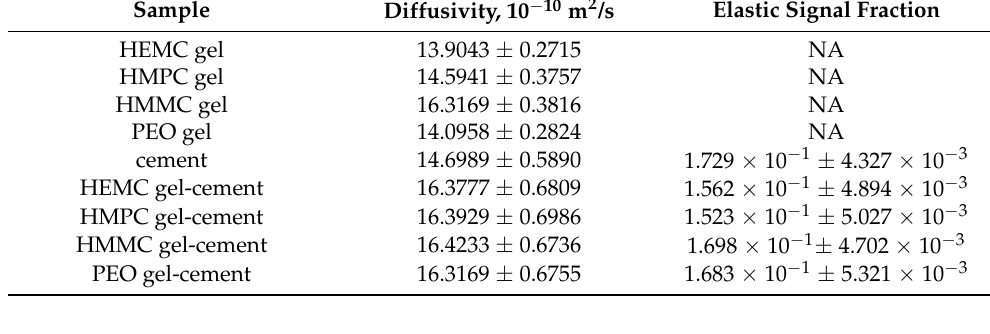
Figure 11. Hydration Calorimetry results for neat cement and gel-cement pastes containing 4 mass % HEMC and HEMC at a gel/cement ratio of 0.27. Table 1. Diffusion coefficients obtained from fit of the HWHM for DQ 2 + offset.